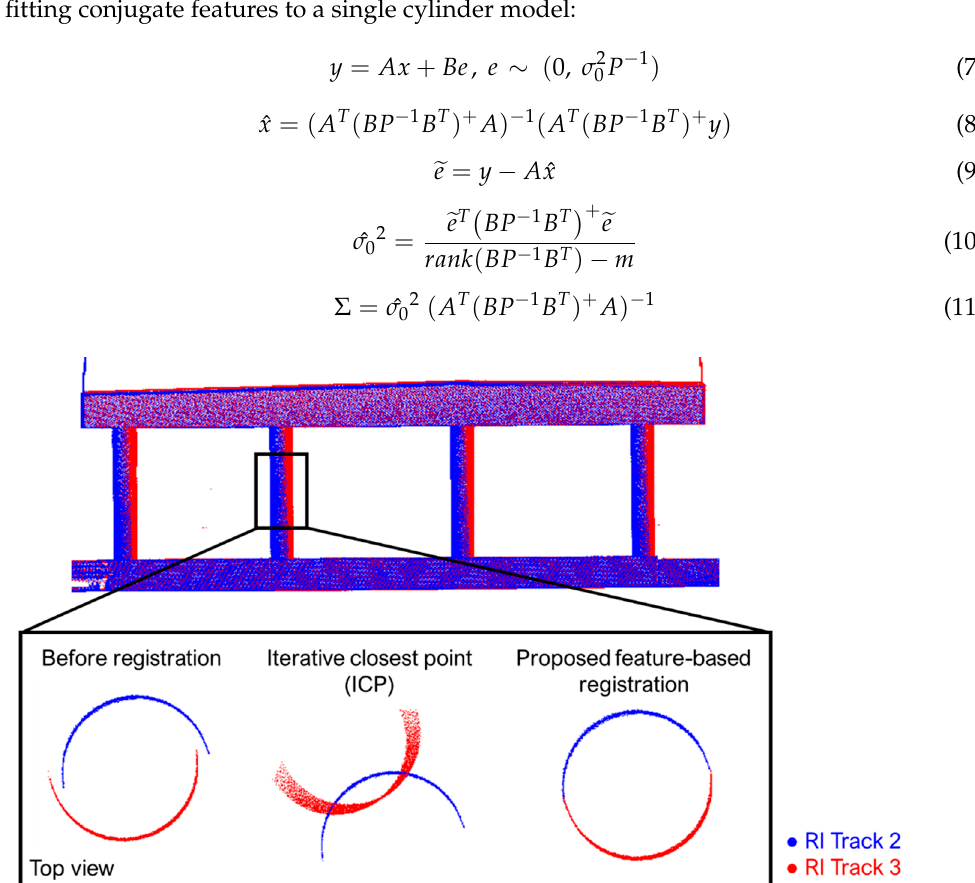
Figure 10. Sample registration results using the iterative closest point (ICP) and proposed approach, showing a cylindrical feature before and after registration. showing a cylindrical feature before and after